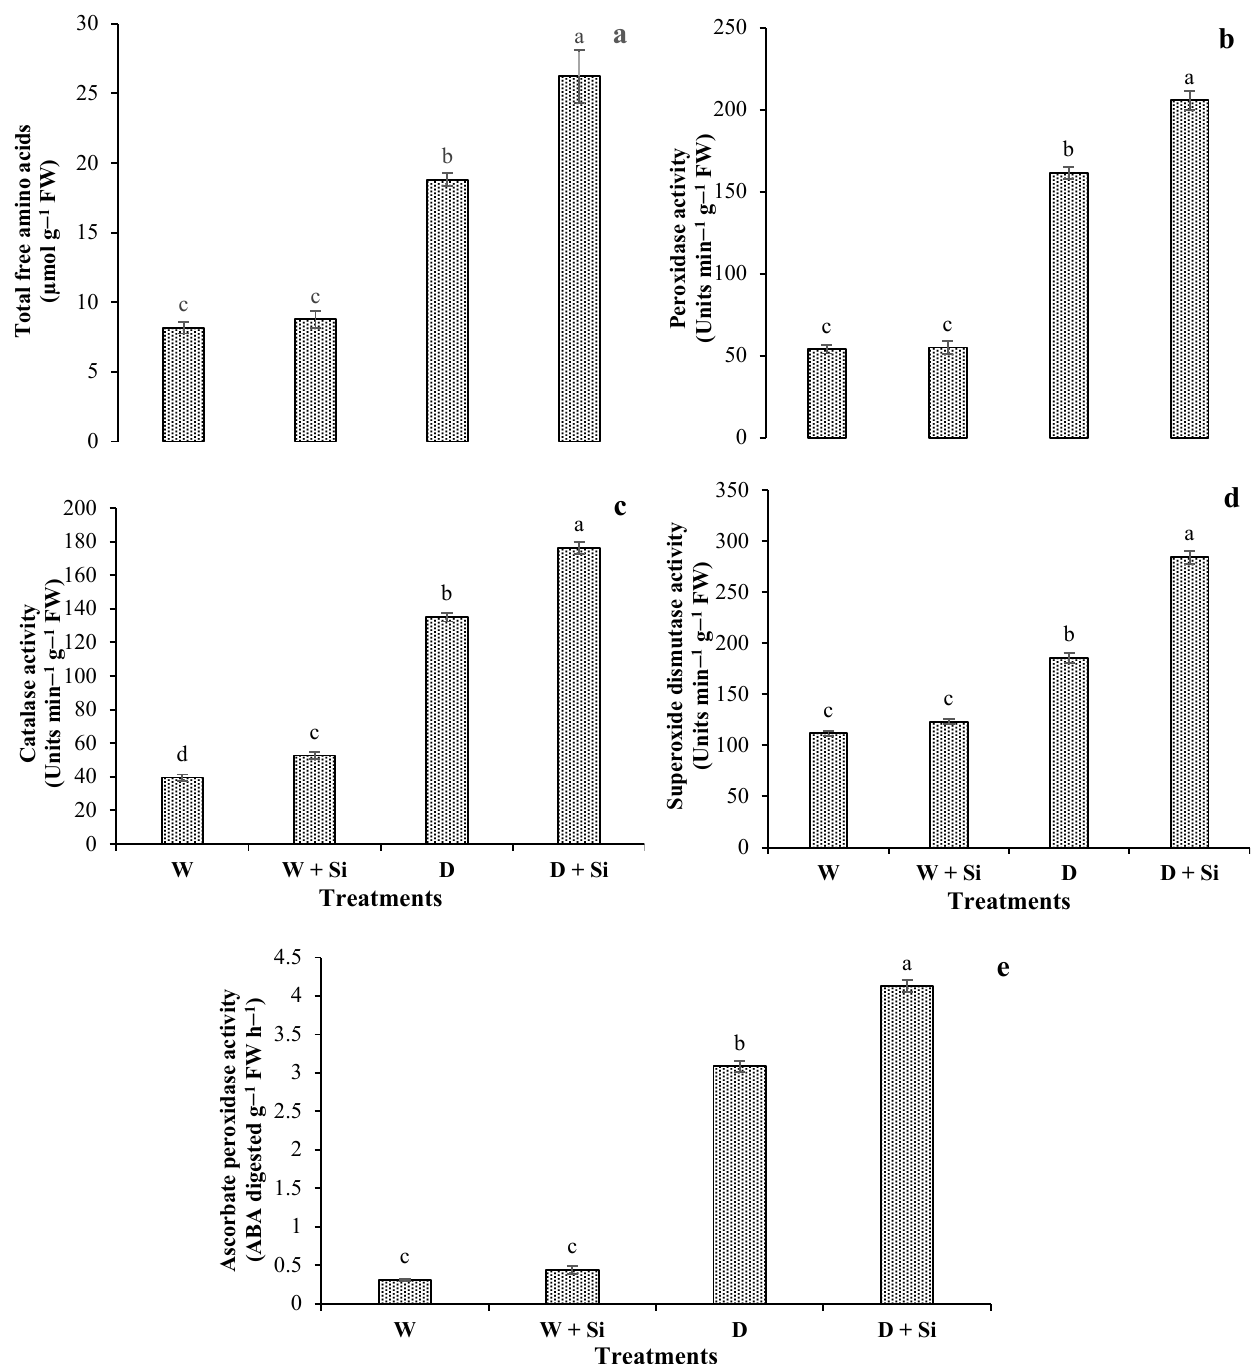
Figure 2. Impact of foliar Si supplementation on accrual of osmoprotectants and activities of antioxi- dant enzymes, total free amino acids ( a ), peroxidase ( b ), catalase ( c ), superoxide dismutase ( d ) and ascorbate peroxidase ( e ) of Gerbera jamesonii under water-deficient conditions. Each bar shows a mean of four replicates ± SE. Dissimilar lettering illustrates significant statistical differences at p ≤ 0.05 after applying LSD